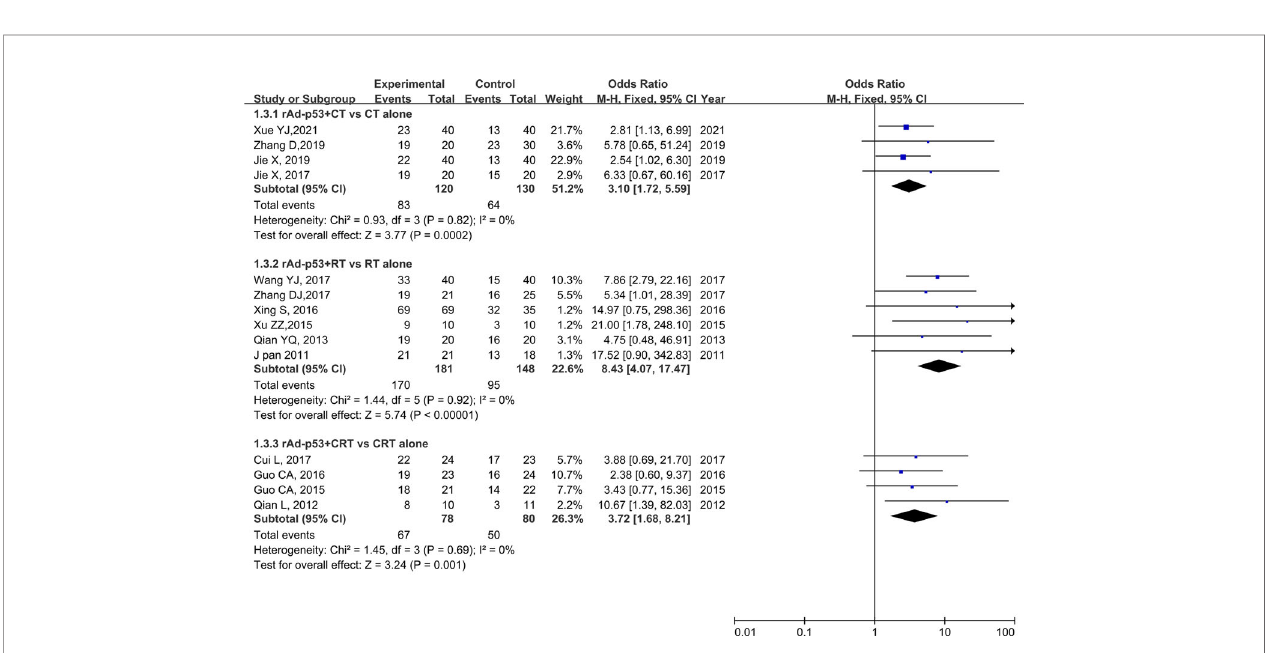
FIGURE 7 | Forest plot for subgroup analysis of ORR based on CT/RT/CRT. CT, chemotherapy; RT, radiotherapy; CRT, chemoradiation